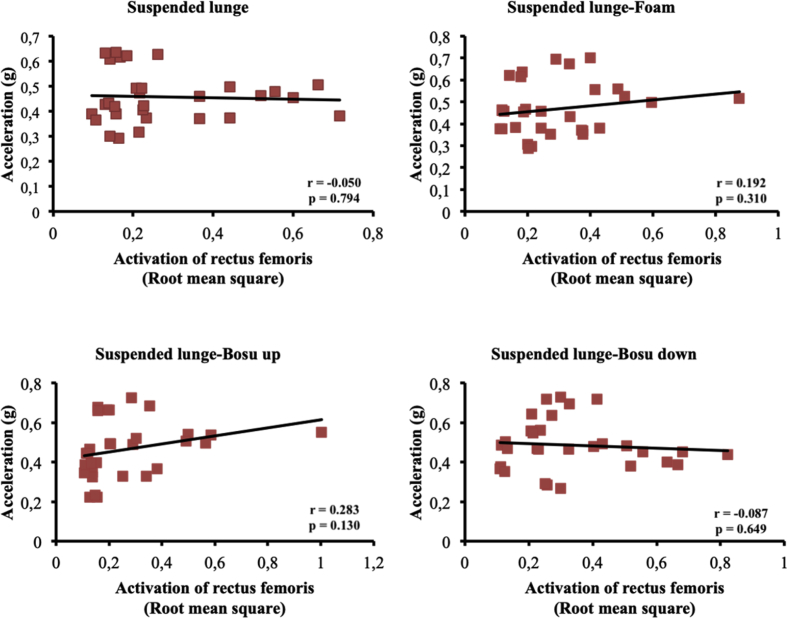
Correlation between rectus femoris activation and acceleration values under suspended lunge conditions.